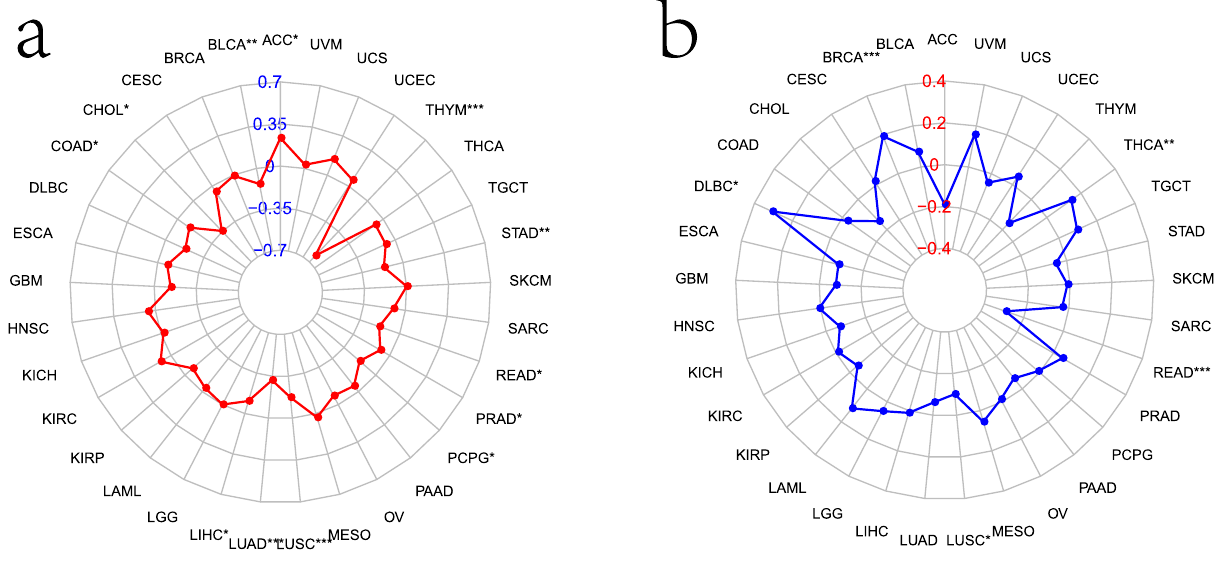
Figure 7. Relationships between PDLIM2 gene expression and TMB, MSI of TCGA dataset in Pan-cancer by R (3.6.3 version; The R Project for Statistical Computing, Vienna, Austria). ( a ) The radar chart illustrated the association between PDLIM2 and TMB in 33 cancer types. The red curve represents the correlation coefficient, and the blue value represents the range. ( b ) The radar chart illustrated the relationship between PDLIM2 and MSI in 33 cancer types. The blue curve represents the correlation coefficient, and the green value represents the range. TMB, tumor mutational burden; MSI, microsatellite instability; *P < 0.05, **P < 0.01, and ***P < 0.001. ACC: adrenocortical carcinoma; BLCA: bladder urothelial carcinoma; COAD: colon adenocarcinoma; HNSC: head and neck squamous cell carcinoma; KICH: kidney chromophobe; KIRP: